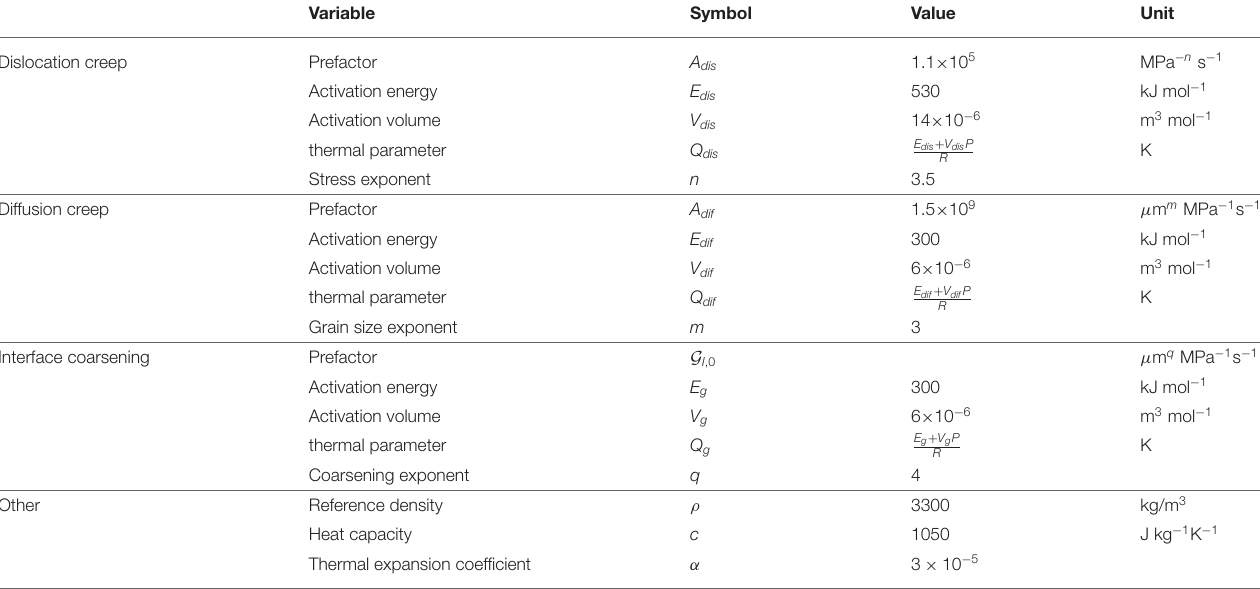
TABLE 1 | Material properties used in this study.